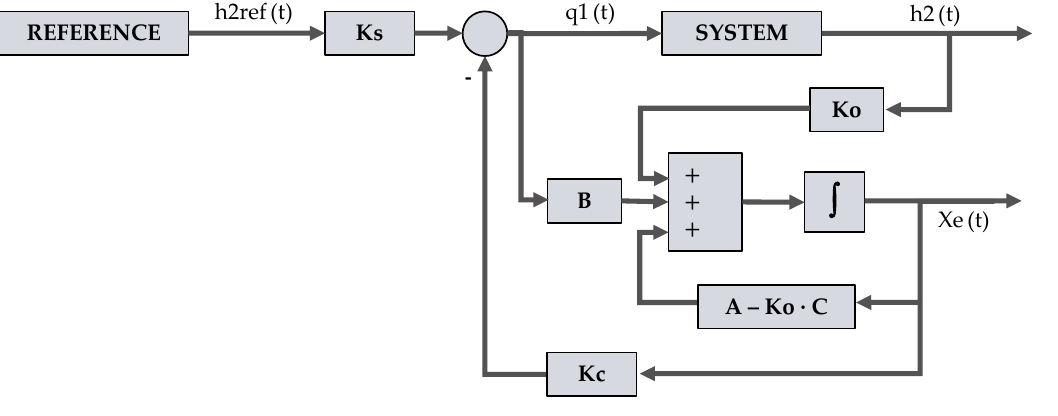
Figure 3. Control schema: Observed state feedback.